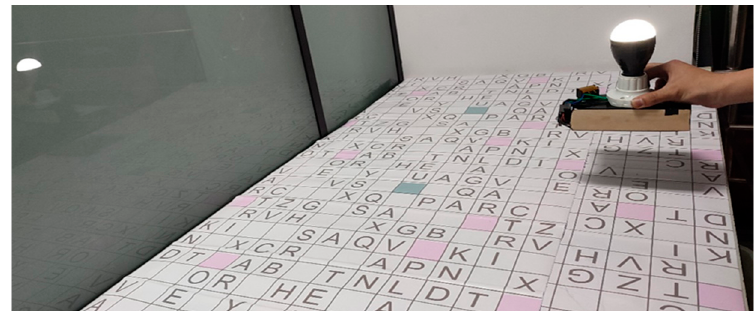
Figure 16. DWPT for handheld lamp.